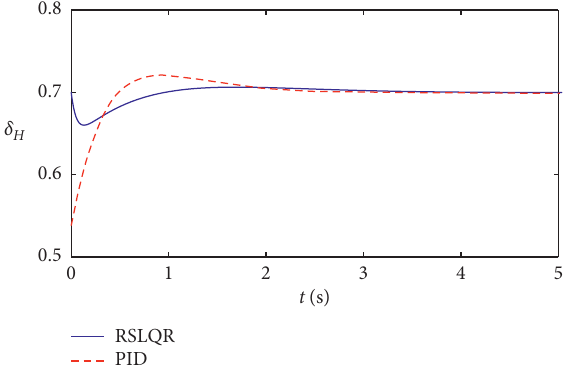
Figure 10: Comparison results of control input.